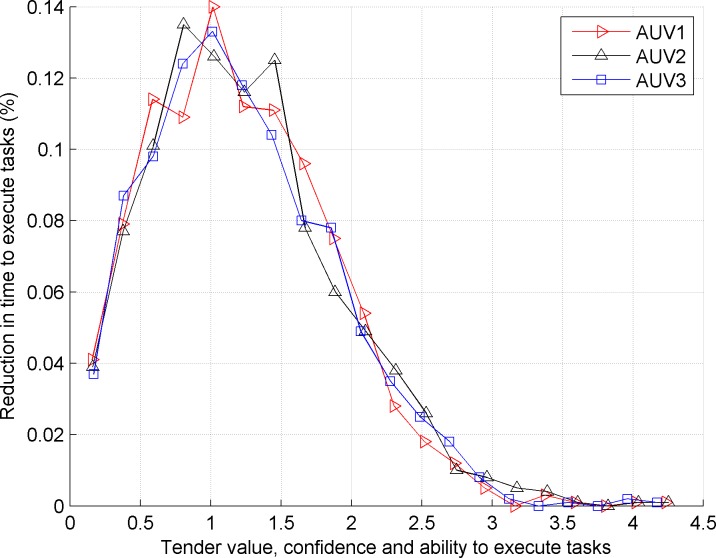
Reduced proportion (%) of AUV1, AUV2, and AUV3 tasks in the improved contract net model.